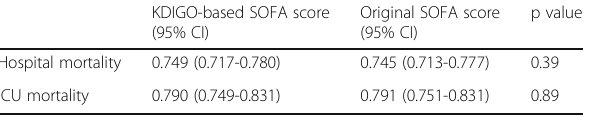
Table 2 (abstract 0065). Area under the receiver operating characteristic curves of the KDIGO-based and original SOFA score for hospital and ICU mortality